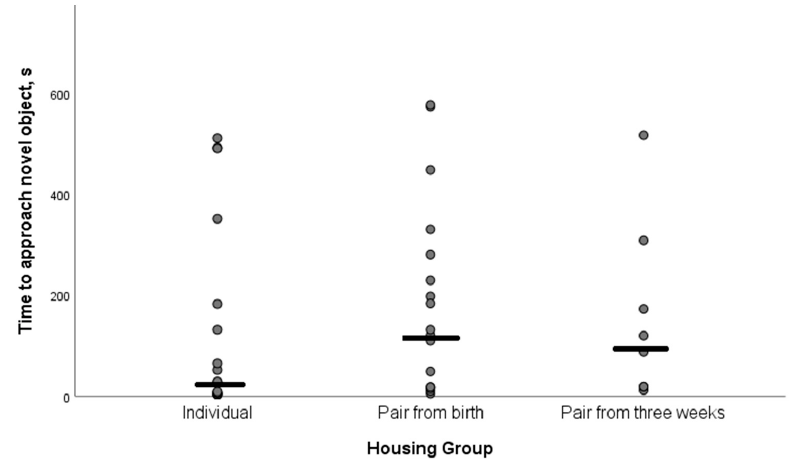
Figure 5. A scatter graph demonstrating the spread of time taken to approach the novel object for each housing group of calves. Each dot represents either an individual calf in the individually housed calf group, or the time taken for the first calf to touch the novel object in the pair housed groups. The horizontal line shows the median time for that group to approach the object.